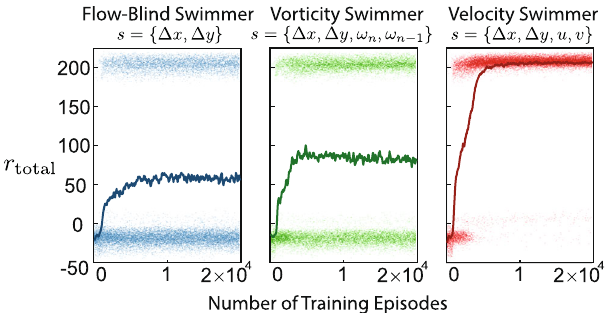
Fig. 2 Evolution of the cumulative reward during training for the three RL swimmers. The cumulative rewards for each episode are plotted as points, and a moving average with a window of 201 episodes is plotted with a solid line. Because the swimmer gains a bonus of 200 for reaching the target, successful episodes are clustered around a reward of 200 while unsuccessful episodes are clustered below